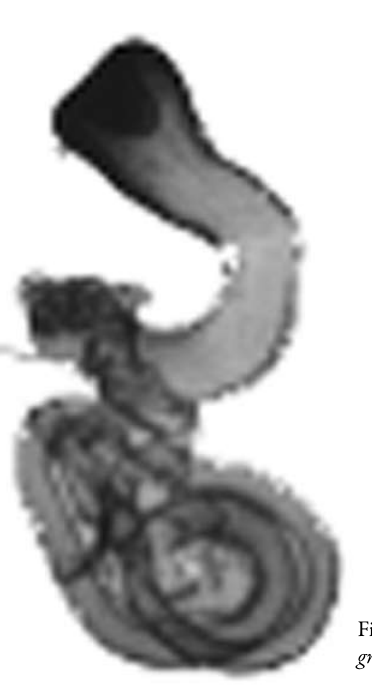
Fig, 6. spermatheca of A theta